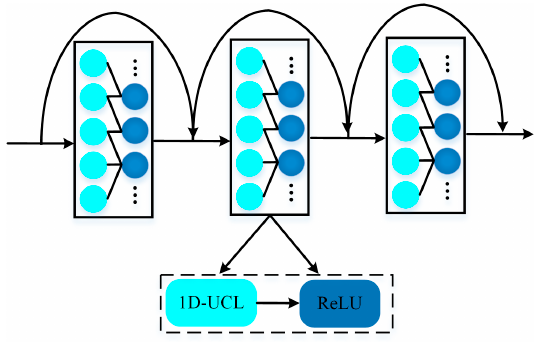
Figure 2. Densely connected residual block (DCRB): 1D-UCL, one-dimensional unshared convolu- tional layer.